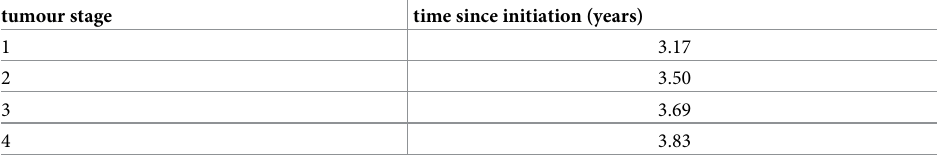
Table 3. The mapping from tumour stage to time since initiation for tongue cancer assuming exponential